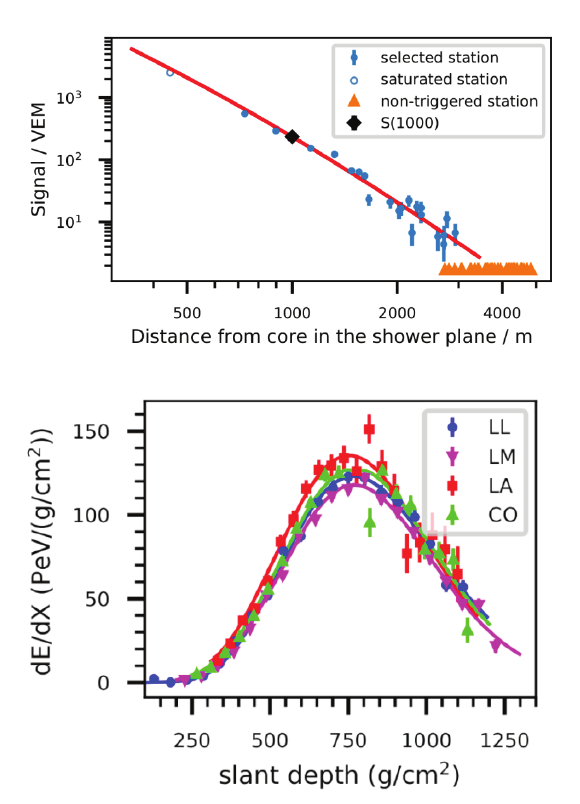
Figure 5. Top : The lateral distribution function of the most en- ergetic hybrid event detected at the Pierre Auger Observatory, PAO100815, #84. Bottom : Profiles of the energy deposits re- constructed in each FD site. The solid lines correspond to fits to the profiles of the energy deposition using the universal shower profile function.